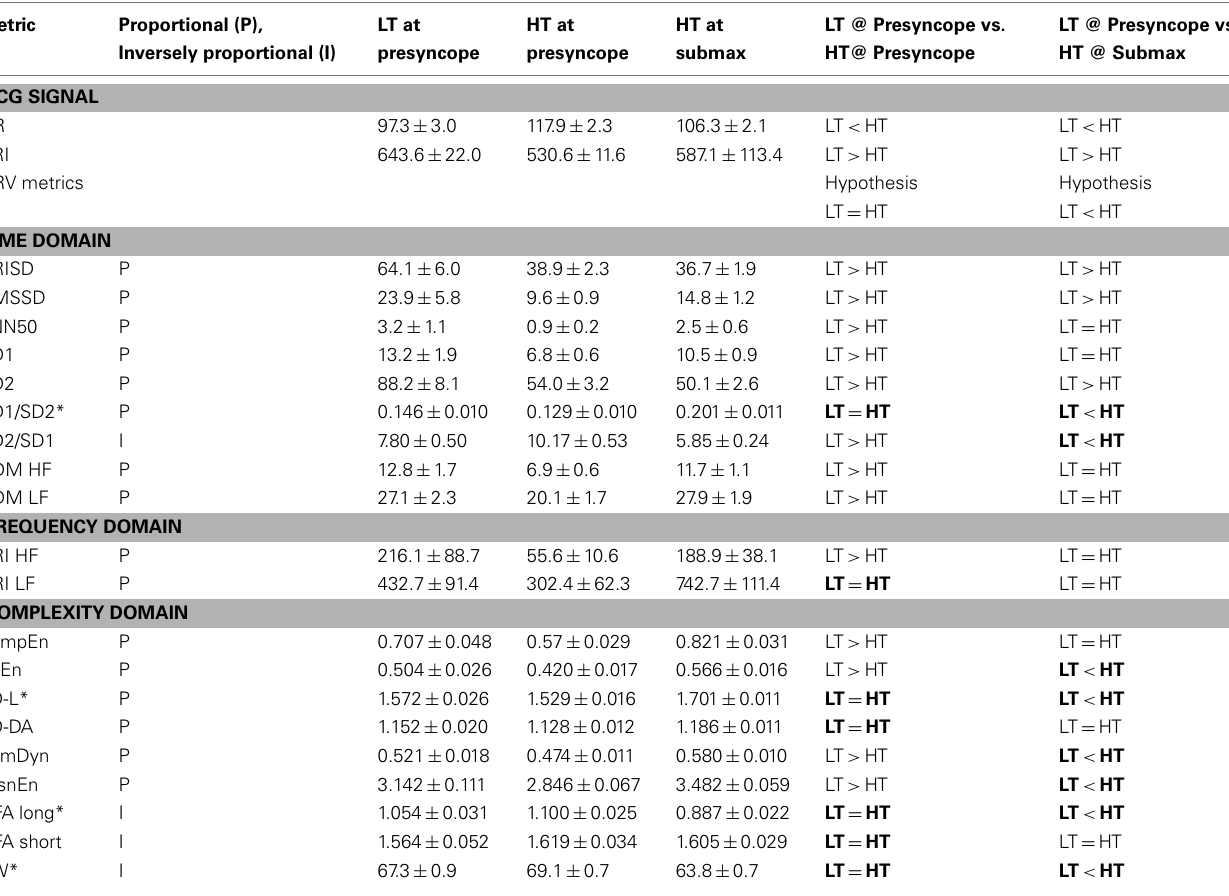
Table 3 | HR, RRI, and HRV metrics in LT at presyncope, HT at presyncope, and HT at submax. Metric Proportional (P), Inversely proportional (I)